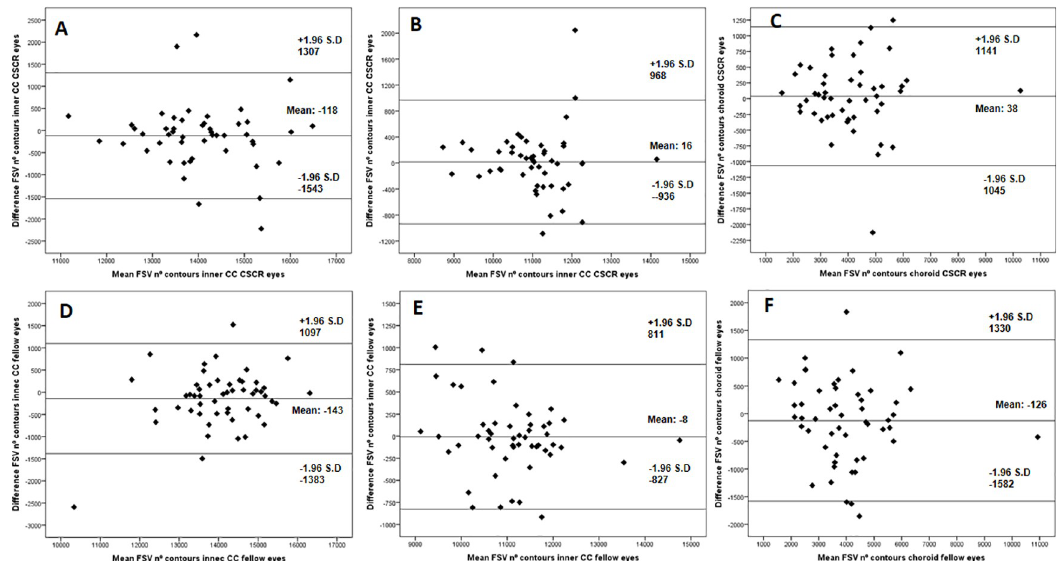
Fig 6. Bland-Altman plots showing the flow signal voids (FSV) number of contours in the different segmentations studied (A and D: inner choriocapillaris (CC) in CSCR and fellow eyes respectively; B and E: outer CC in CSCR and fellow eyes respectively, C and F: choroid in CSCR and fellow eyes